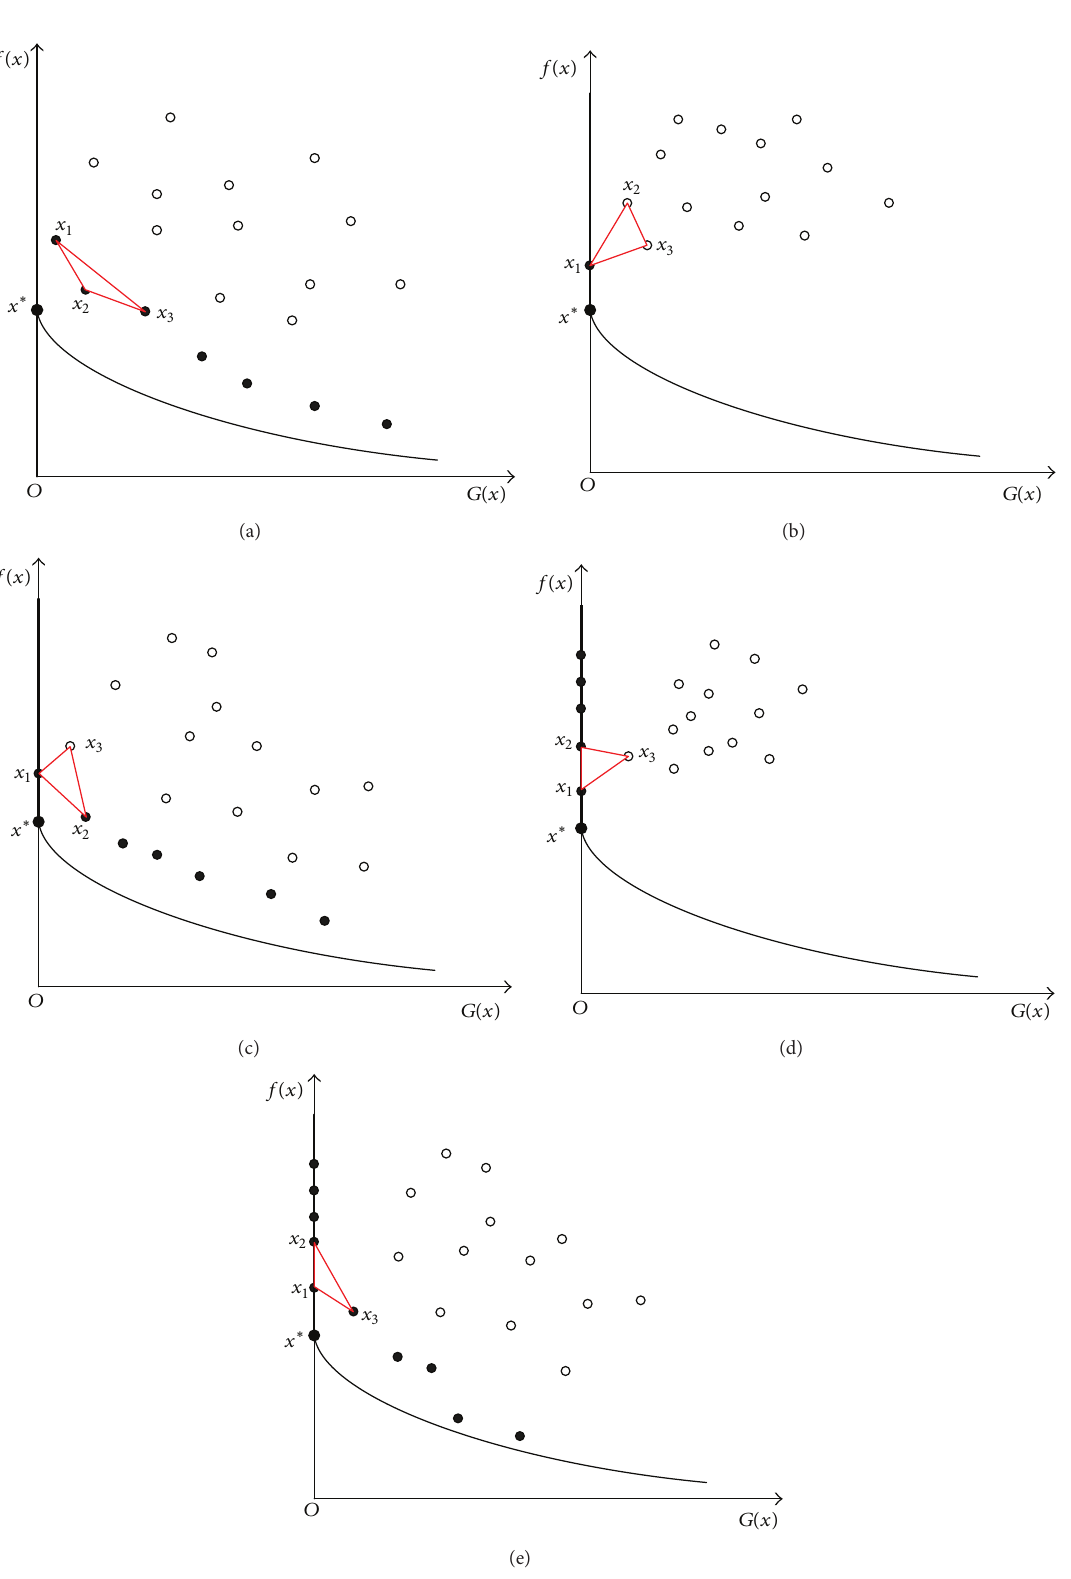
Figure 4: Solutions selected to perform SPX in different